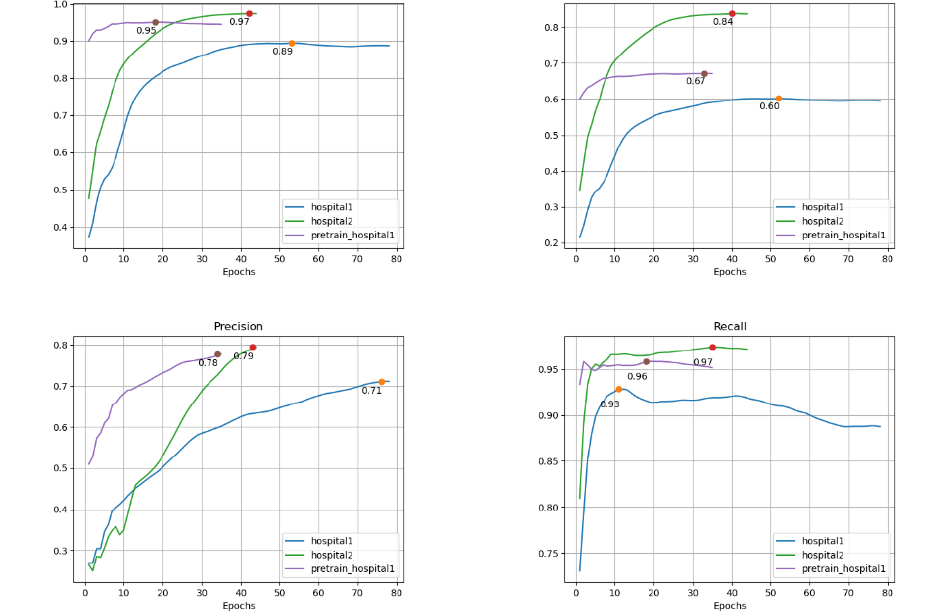
Figure 13. Performance metrics for the Mobility Aids dataset.